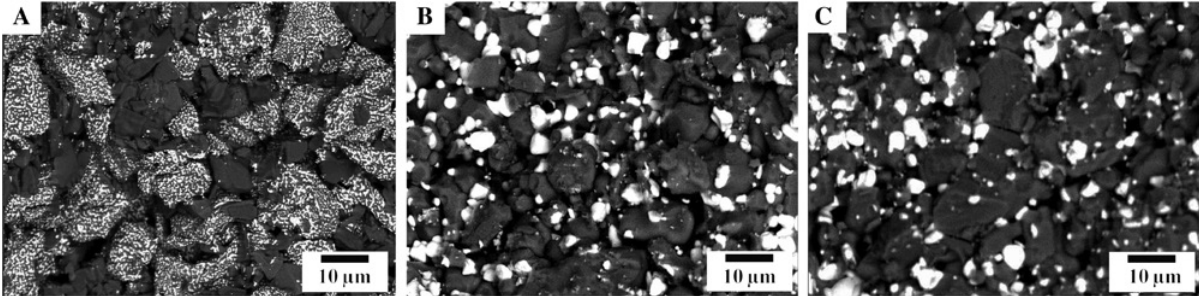
Figure 9 SEM photographs of samples (A) Z